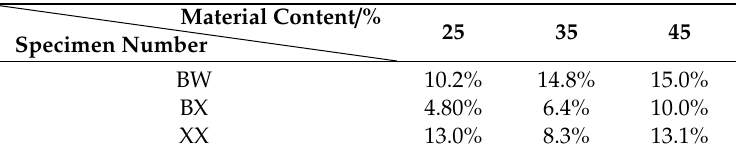
Table 13. Standard deviation analysis comparison table of compressive strength of di ff erent thermal insulation materials.